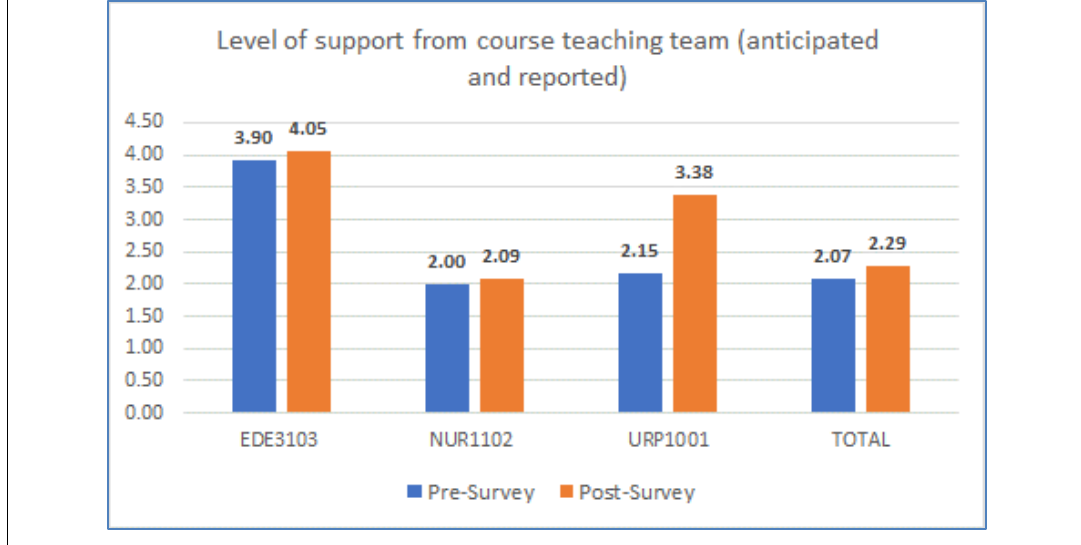
Figure 3. Level of student support was greater than anticipated in all